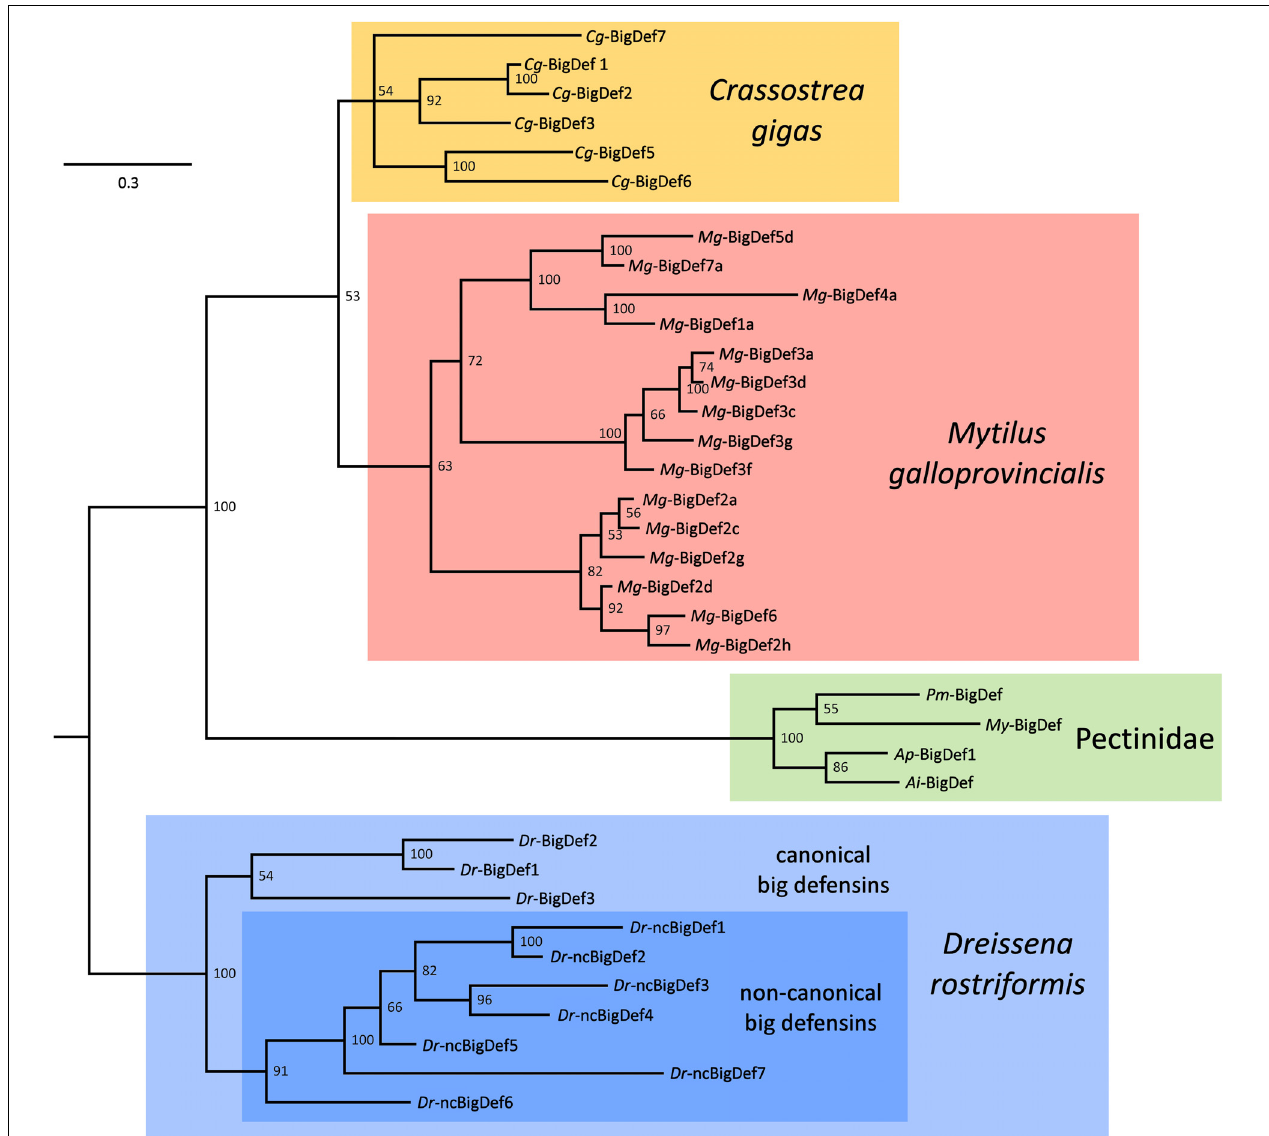
FIGURE 5 | Simplified phylogeny of bivalve big defensins, exemplified by variants found in the genomes and transcriptomes of the oyster Crassostrea gigas ( Cg -BigDefs), the mussel Mytilus galloprovincialis ( Mg -BigDefs), the clam Dreissena rostriformis ( Dr -BigDefs and ( Dr -ncBigDefs) and the four scallop species Pecten maximus ( Pm -BigDef), Mizuhopecten yessoensis ( My -BigDef), Argopecten purpuratus ( Ap -BigDef1) and Argopecten irradians ( Ai -BigDef). The tree was obtained through Bayesian inference using MrBayes v3.2.1, with two parallel MCMC analyses run for 500, 000 generations each, based on a VT + G model of molecular evolution. For simplicity’s sake, variants sharing > 90% pairwise identity have been removed. The tree was rooted on D. rostriformis , as the only member of the superorder Imparidentia. Posterior probability support values are shown for each